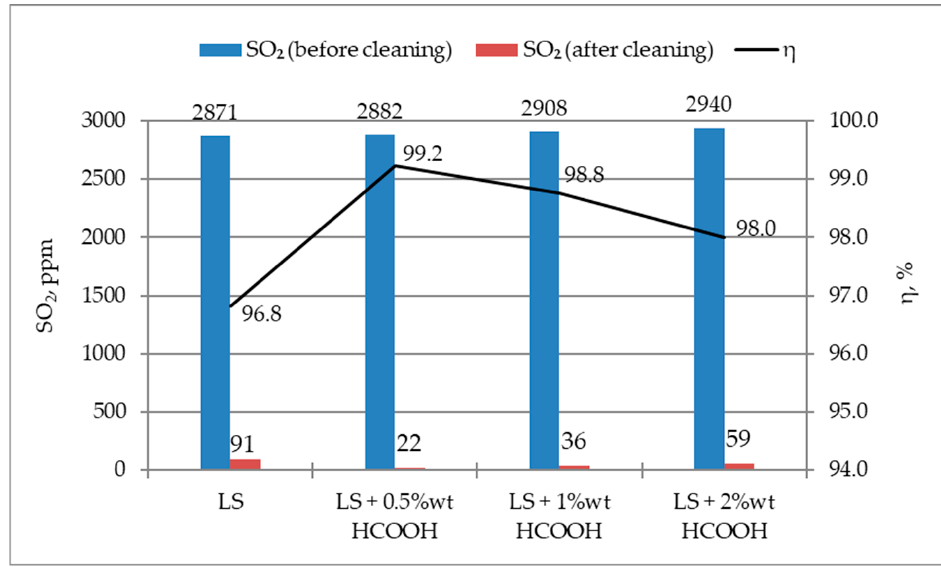
Figure 5. SO 2 values before and after flue gases cleaning and absorption efficiency.